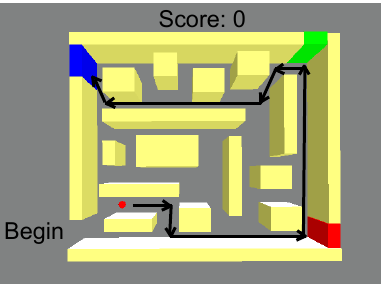
Fig. 3. Exercise in the haptic maze. The target trajectory motion is depicted in black. The proxy (red dot) changes its color to indicate the wall color that the user has to touch in the indicated order (red, green and blue).